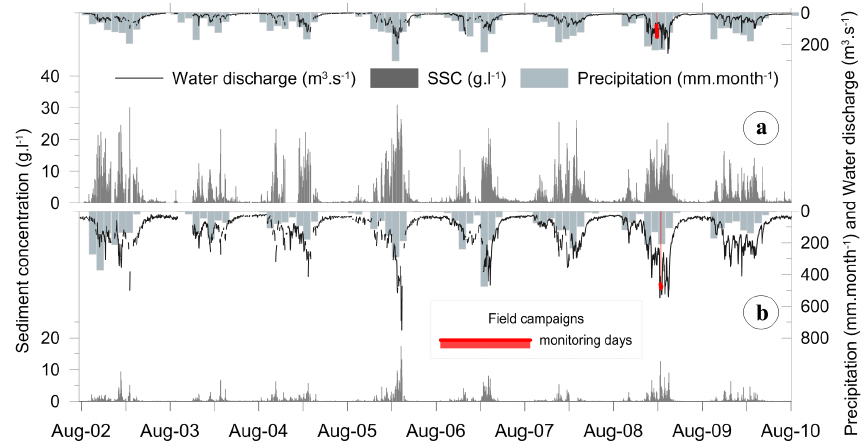
Fig. 5. Historic (9yr) observed river discharge (top), precipitation and suspended sediment concentration (SSC). (a) Tablachaca station mean annual: SSC 3.43gL − 1 , discharge 28m 3 s − 1 and precipitation 808.2mm; (b) Santa station mean annual: SSC 0.64gL − 1 , 105.4m 3 s − 1 and precipitation 810.4mm. Days of the field data collection are in red; see Table 2 for sample Figure 5. Historic (9-year) observed river discharge (top), precipitation and suspended 3 sediment concentration (SSC). a) Tablachaca station mean annual: SSC 3.43 g.L -1 , discharge 4 28 m 3 .s -1 and precipitation 808.2 mm and b) Santa station mean annual: SSC 0.64 g.L -1 , 105.4 5